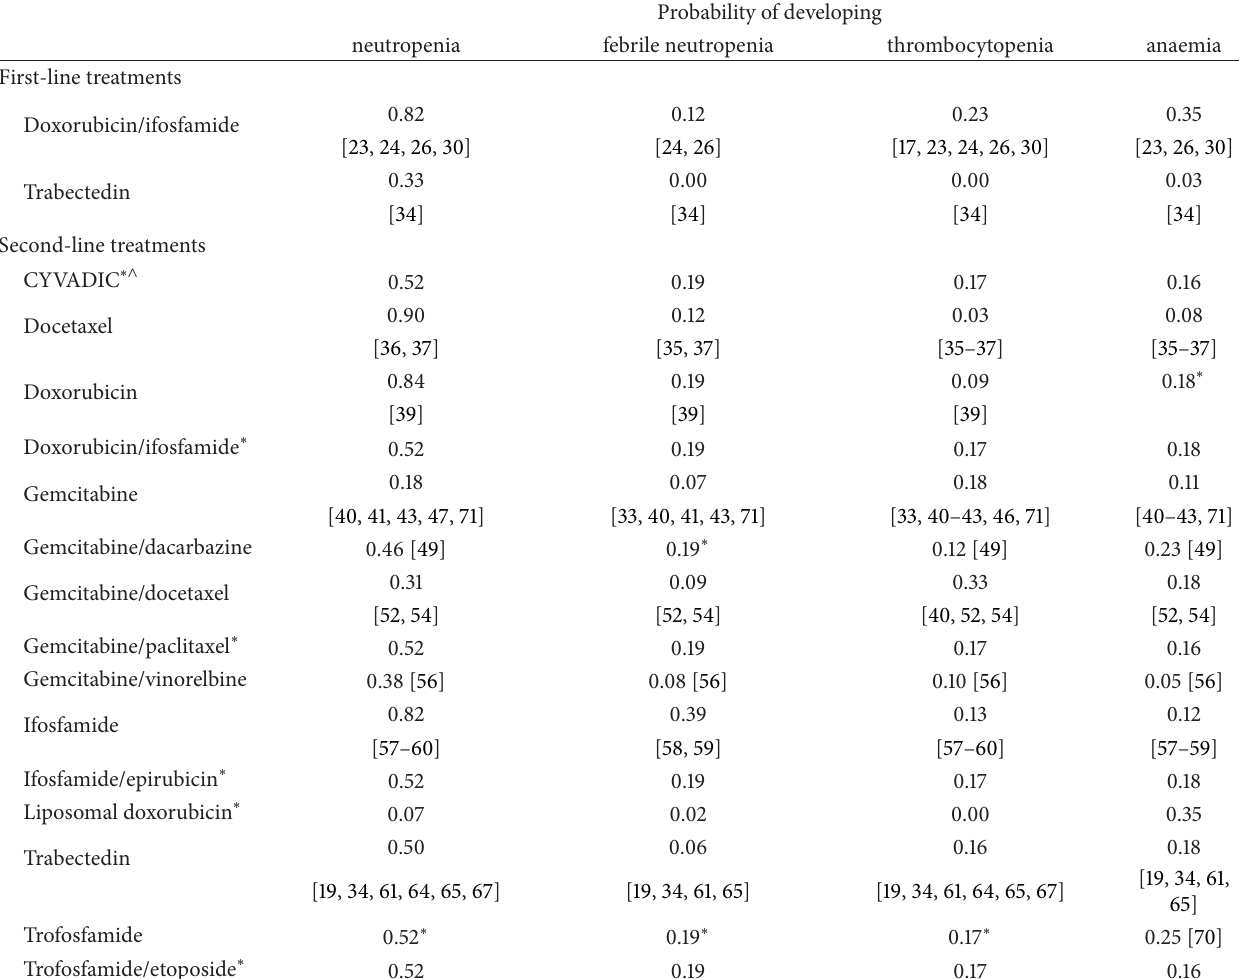
Table 4: Probabilities of patients developing haematological toxicities stratified by chemotherapy